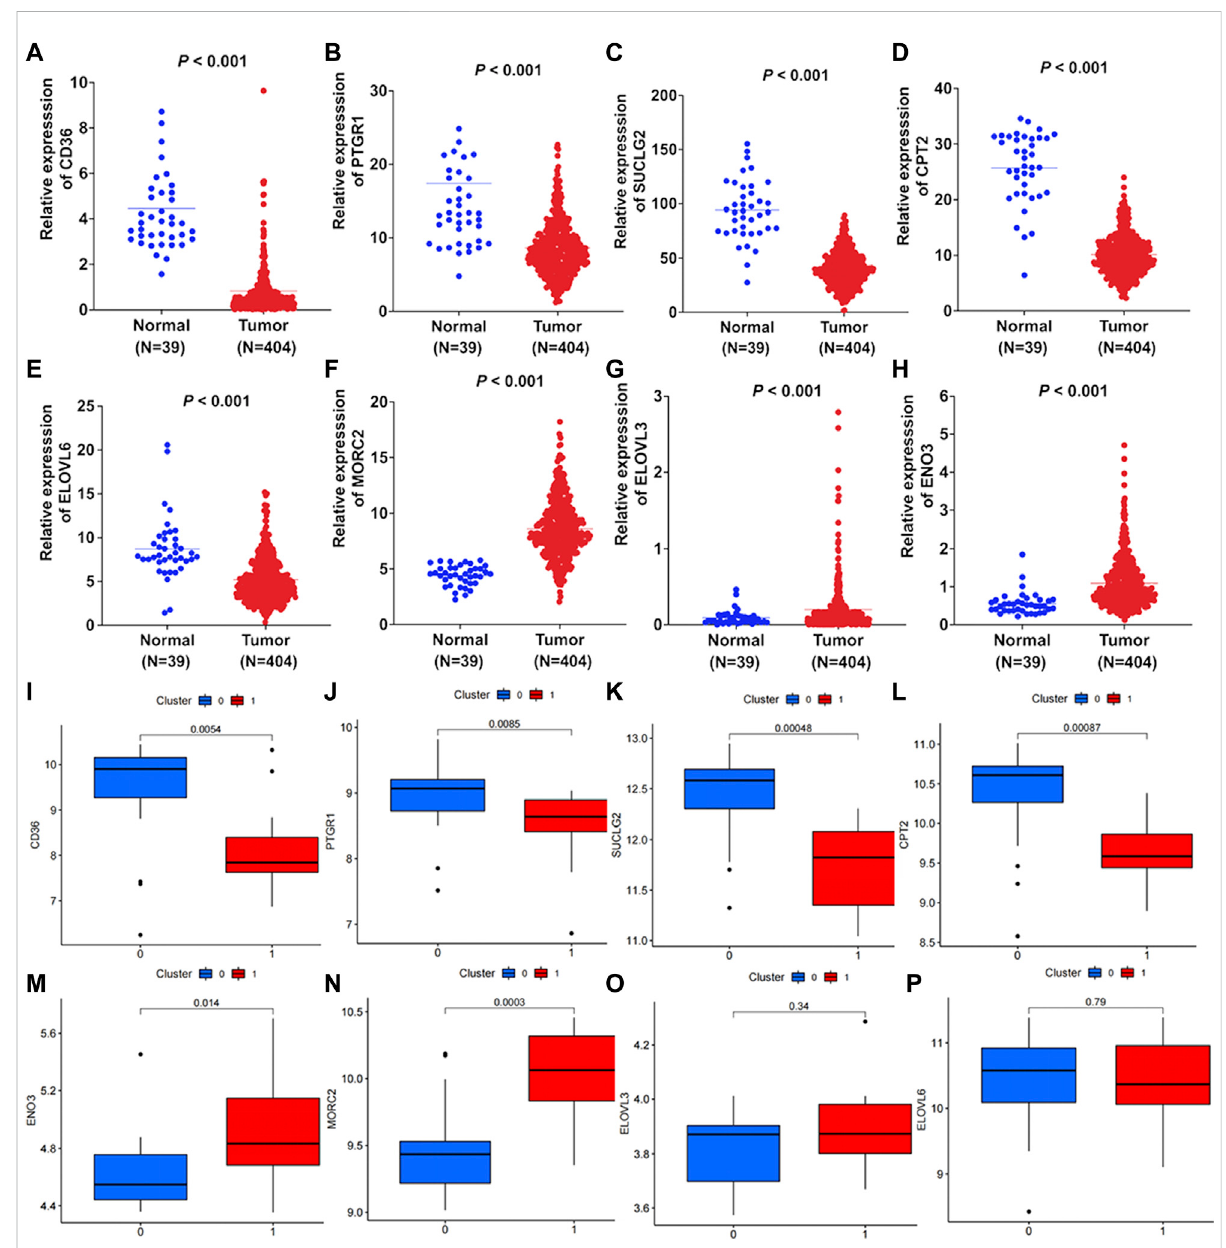
FIGURE 8 DifferentialexpressionoftheFAM-relatedgenes.Differentialexpressionof (A) CD36, (B) PTGR1, (C) SUCLG2, (D) CPT2, (E) ELOVL6, (F) MORC2, (G) ELOVL3 and (H) ENO3 between colon adenocarcinoma tissues and normal tissues were compared according to TCGA-COAD cohort. GEO dataset validated the differential expression of (I) CD36, (J) PTGR1, (K) SUCLG2, (L) CPT2, (M) ENO3, (N) MORC2, (O) ELOVL3 and (P) ELOVL6 between tumor tissues and normal tissues. There were 17 pairs of normal tissues and tumor tissues in the GEO